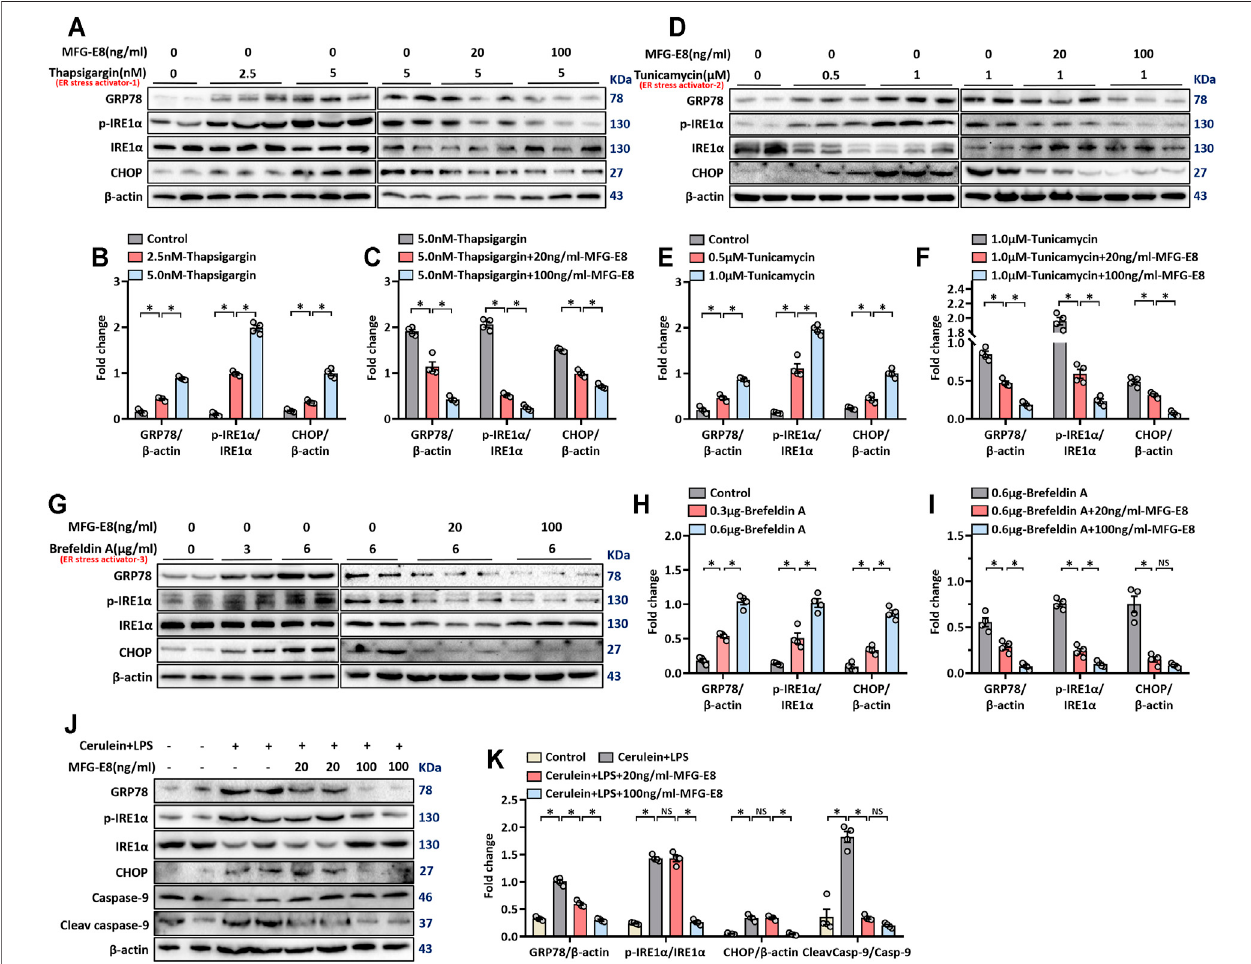
FIGURE 1 | rhMFG-E8 alleviates ER stress in pancreatic exocrine acinar cells. Model 1: Pancreatic AR42J cells (5 × 10 5 /well) were treated with 2.5 or 5 nM thapsigargin with or without 20or 100 ng/ml MFG-E8 for 24 h. Model 2: Pancreatic AR42J cells (5 × 10 5 /well) were treated with0.5 or 1 μ Mtunicamycin with orwithout 20 or 100 ng/ml MFG-E8 for 24 h. Model 3: Pancreatic AR42J cells (5 × 10 5 /well) were treated with 3or 6 μ g/ml brefeldin A with or without 20or 100 ng/ml MFG-E8 for 24 h. Model 4: Pancreatic AR42J cells (5 × 10 5 /well) were treated with 100 nmol/L cerulein and 10 ng/ml LPS with or without 20 or 100 ng/ml MFG-E8 for 24 h. (A – I) Western blot analysis of the expression of GRP78, phospho-IRE1 α , IRE1 α and CHOP in the AR42J cells; (J,K) Western blot analysis of the expression of GRP78, phospho-IRE1 α , IRE1 α , CHOP, caspase-9, and cleaved caspase-9 in the AR42J cells. n (cid:1) 4 – 6/group, error bars indicate the SEM; p p < 0.05 versus Sham group; # p < 0.05versusVehiclegroup.MFG-E8,milkfatglobuleEGFfactor8;GRP78,glucose-regulatedprotein78;CHOP,C/EBPhomologousprotein; LPS,Lipopolysaccharide.